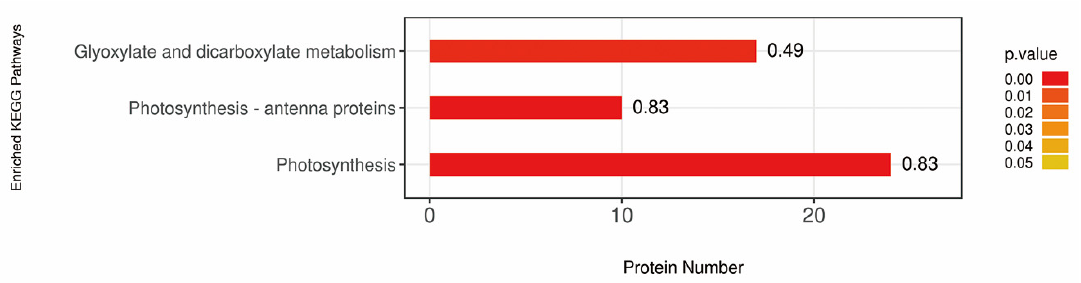
Figure 8. Pathway enrichment analysis of differentially accumulated proteins (DAPs) in OsCpn60 β 1 mutants compared with WT. For the bar graph, color represents the significance of enriched kyoto encyclopedia of genes and genomes (KEGG) pathways. Fisher’s exact test is used to calculate the p -value. The label at the top of the bar chart shows enrichment factor (rich Factor ≤ 1), which represents the proportion of the number of DAPs involved in a KEGG pathway to the number of proteins involved in this pathway among all identified proteins.